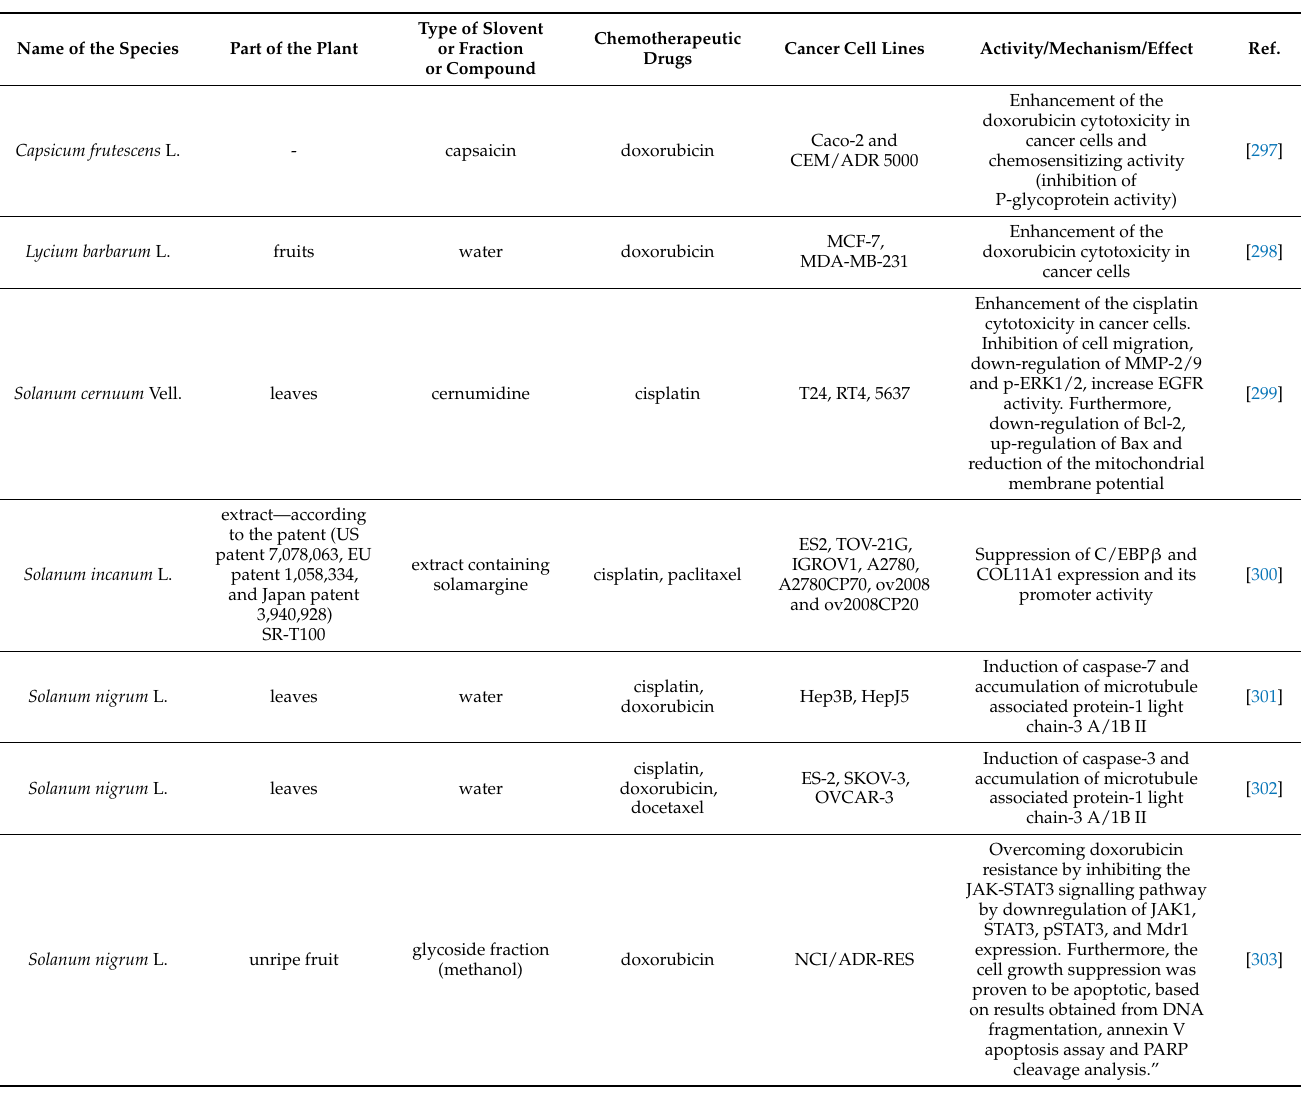
Table 4. Anticancer synergistic effect of chemotherapeutic drugs and plant extracts from the Solanaceae